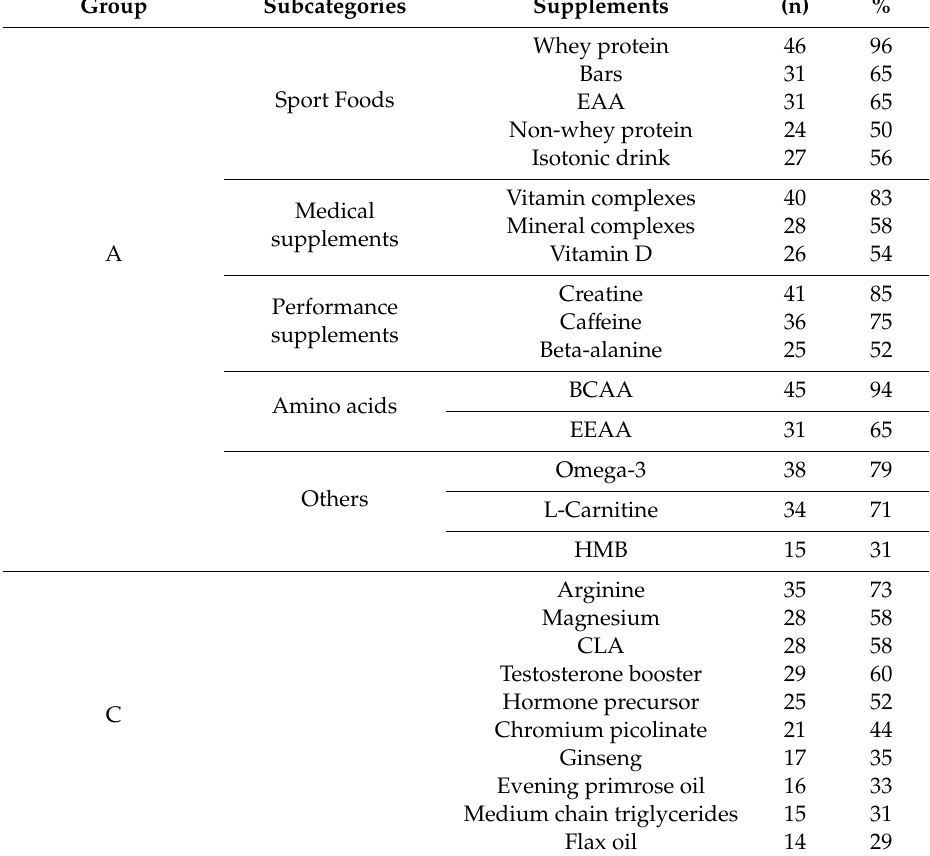
Table 2. Consumption of nutritional supplements (NS) by participants according to the Australian Institute of Sport’s (AIS) classification.